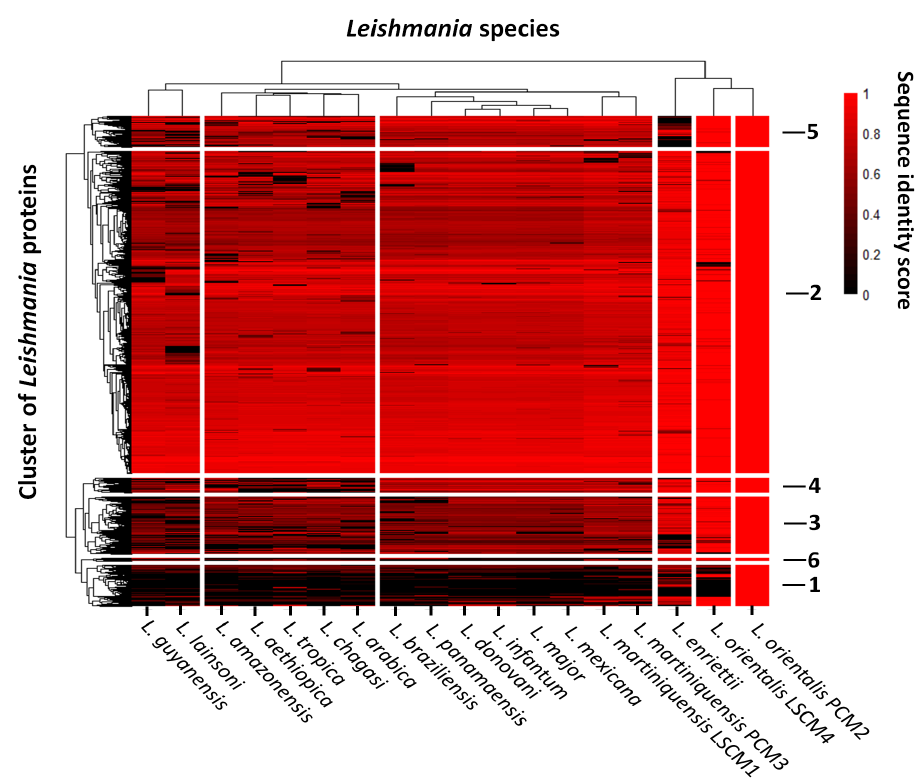
Figure 2. Comparison of protein sequences of the southern isolates of L. orientalis PCM2 and L. martiniquensis PCM3 in Thailand with the northern isolates and other 14 Leishmania species. The protein identity scores were hierarchically clustered into two clusters of Leishmania species (depicted by the column dendrogram) and six groups of proteins (represented by the row dendrogram). Color scale represents the level of sequence identity scores. Numbers labeled on the right of the heatmap indicate the group numbers (1 to 6).